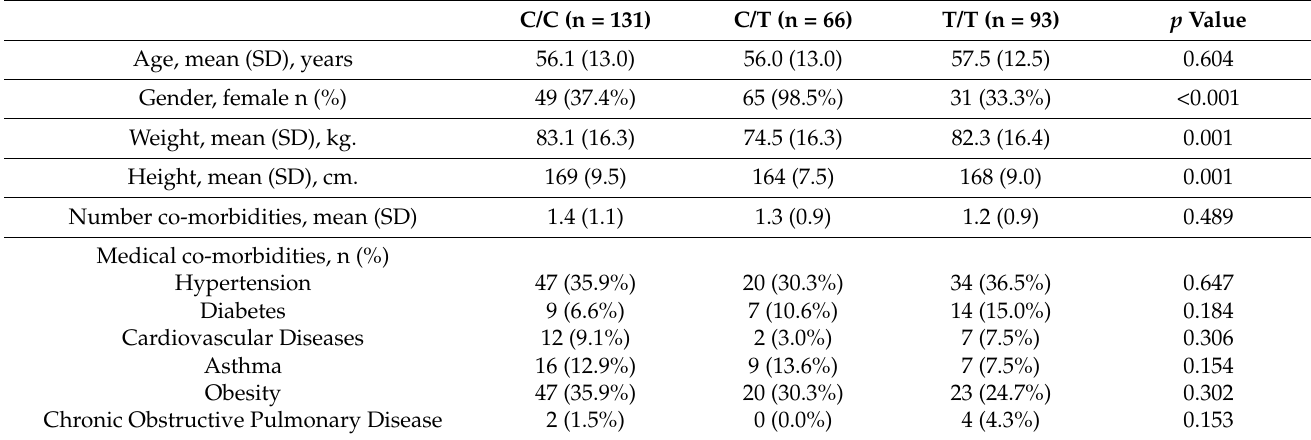
Table 3. Pre-Infection data and post-COVID symptoms according to the ACE2 rs2074192 Polymor- phism Genotype (n =